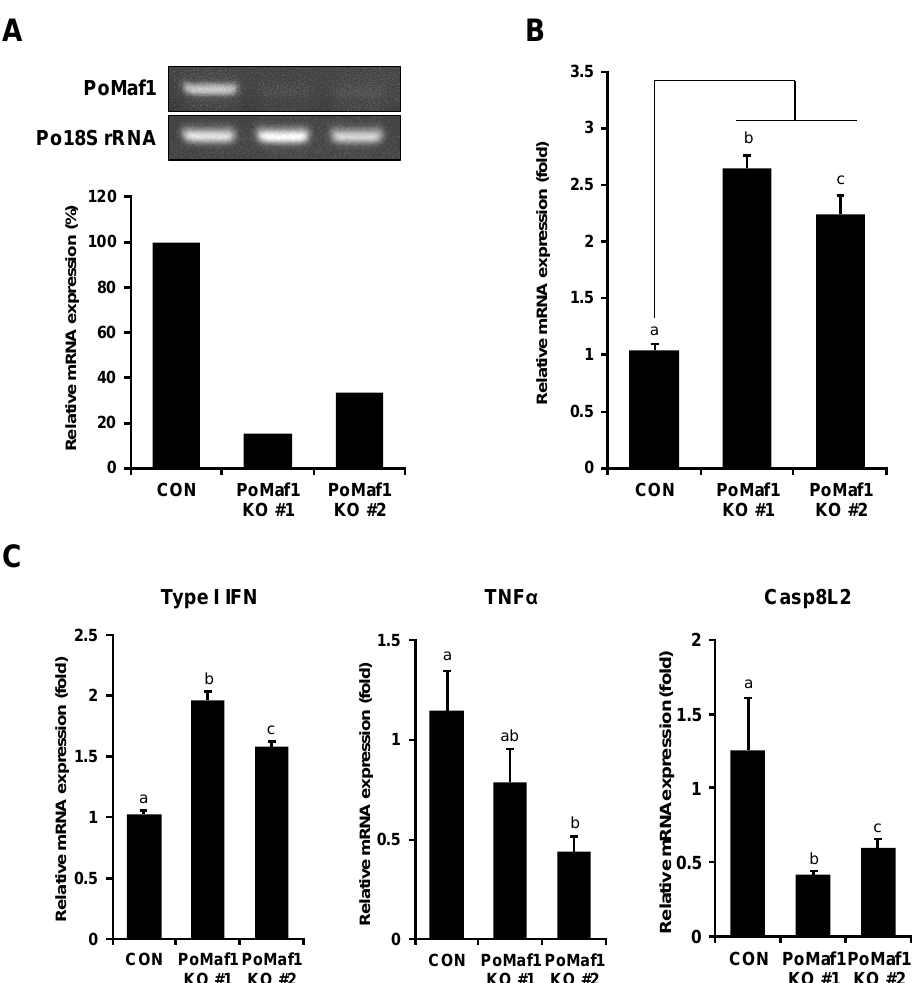
Figure 7. PoMaf1 KO activates VHSV G expression in VHSV-infected cells. ( A ) Relative PoMaf1 mRNA levels in control HINAE cells and PoMaf1 KO cells by RT-PCR. RT-PCR band intensities were measured using ImageJ software (ver. 1.53 g; NIH, Bethesda, MD, USA). ( B ) Relative VHSV G mRNA levels in PoMaf1 KO cells infected with VHSV. HINAE cells were infected with VHSV at a MOI of 0.5 and samples were collected at 48 h post infection. ( C ) Relative mRNA levels of type I IFN, TNF α and Caspase 8 like 2 (Casp8L2) in PoMaf1 KO cells infected with VHSV. HINAE cells were infected with VHSV at a MOI of 0.5 and samples were collected at 48 h post infection. Target mRNA levels in clones #1 and #2 revealed by quantitative real-time PCR, as compared to the cells transfected with vector control (CON). Expression levels were normalized to that of 18S rRNA. Means and standard deviations of three independent replicates are shown. Means with the same superscript letter are not significantly different ( p ≤ 0.05).